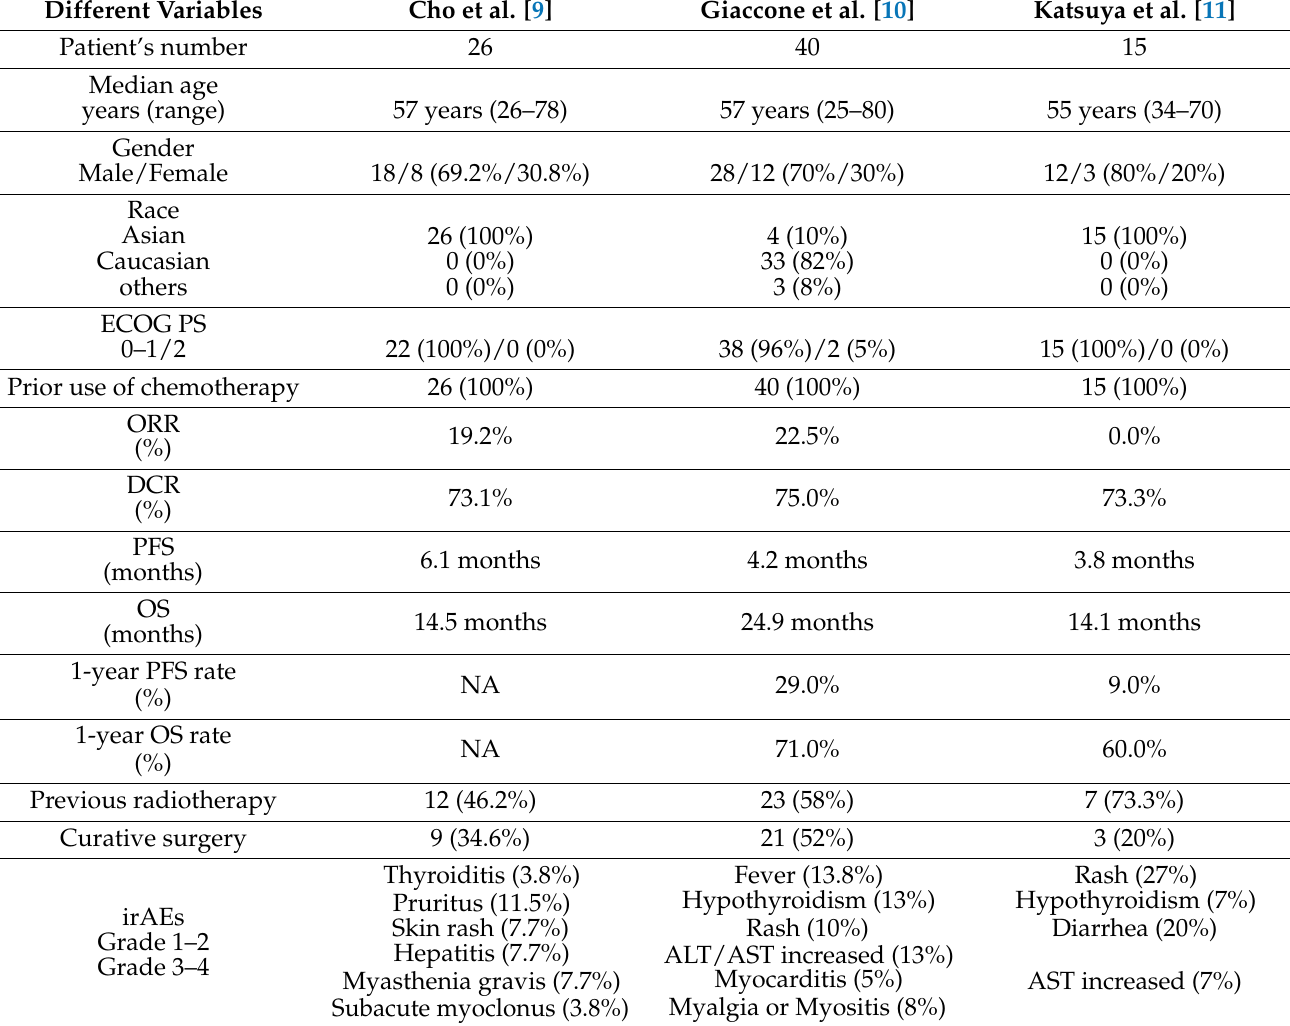
Table 1. Demographics of prospective phase 2 study of PD-1 blockade in thymic carcinoma. Different Variables Cho et al.